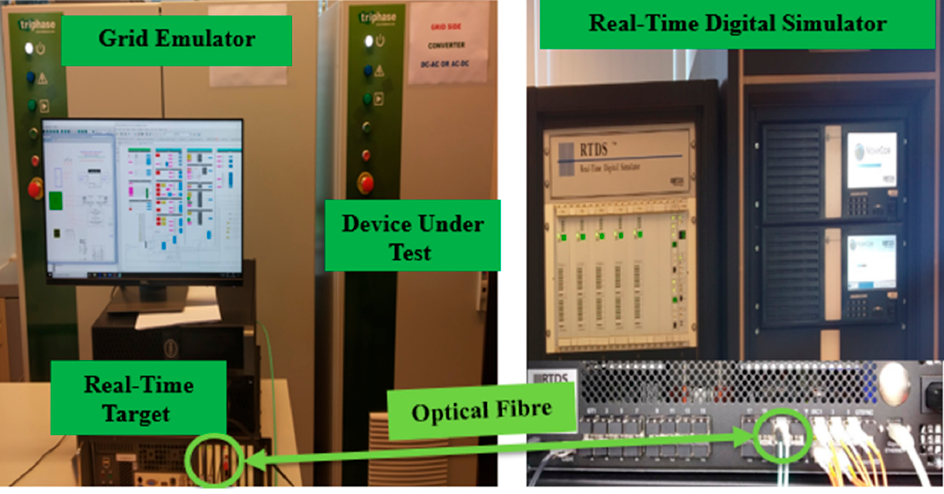
Figure 1. Developed PHIL